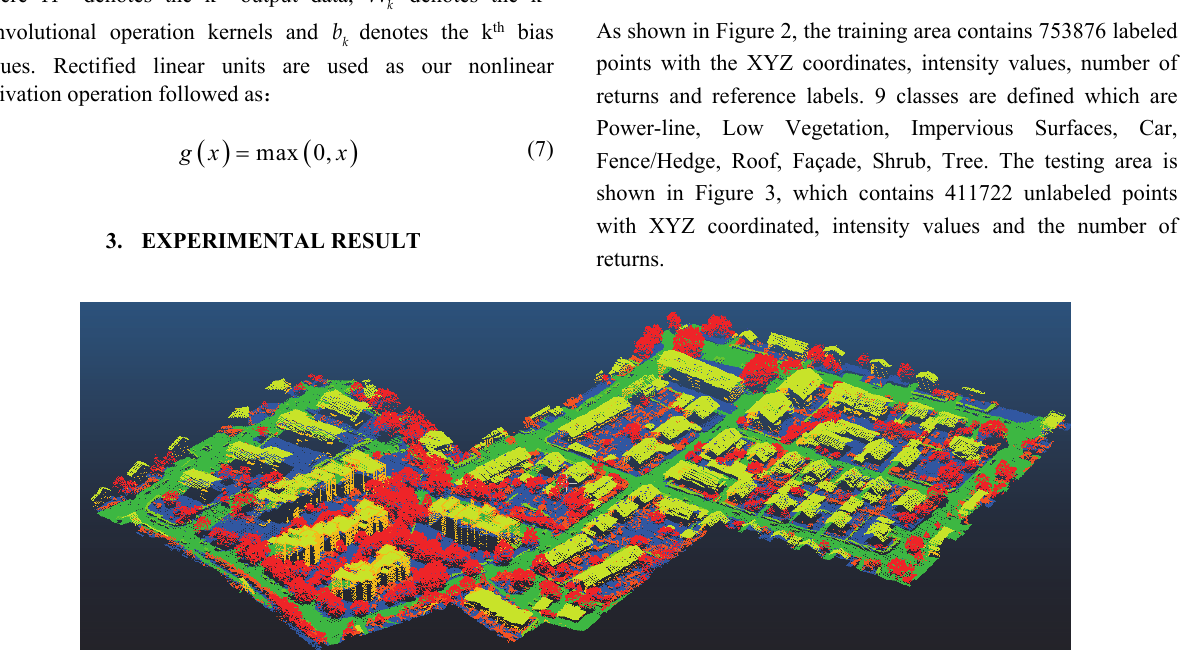
Figure 2. Training set: the color encoding shows the assigned semantic class